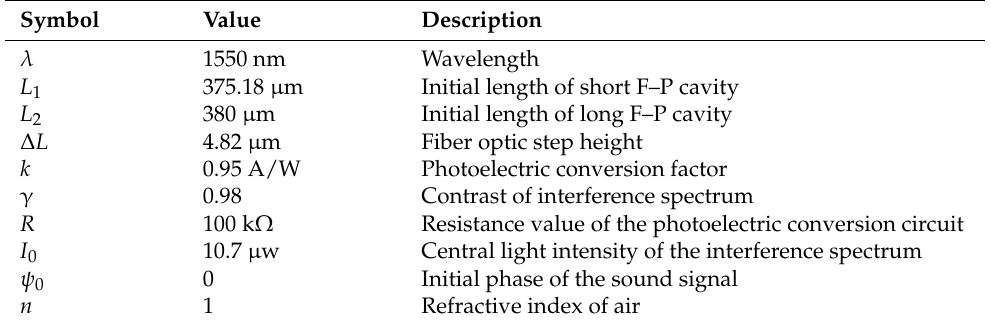
Table 2. Parameters of the